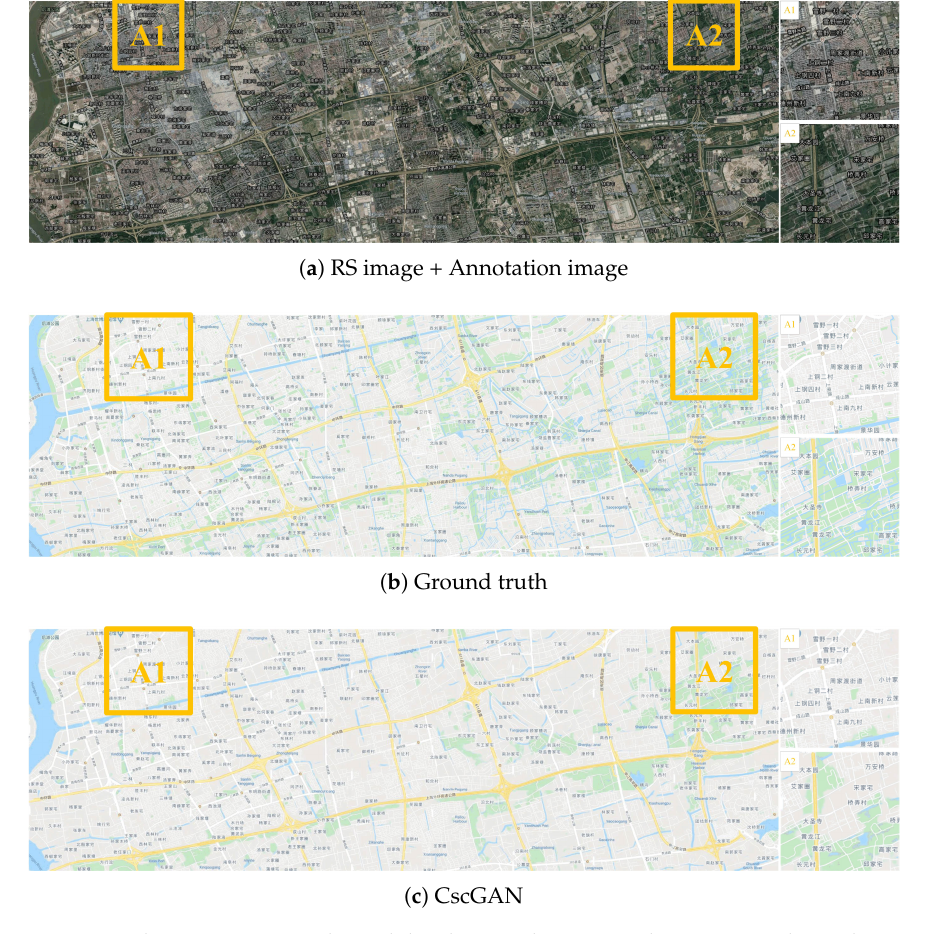
Figure 14. The generation results with level 15 via the proposed CscGAN in the Pudong New Area of Shanghai. For clarity, the zoomed local areas (A1 and A2) are on the right of the